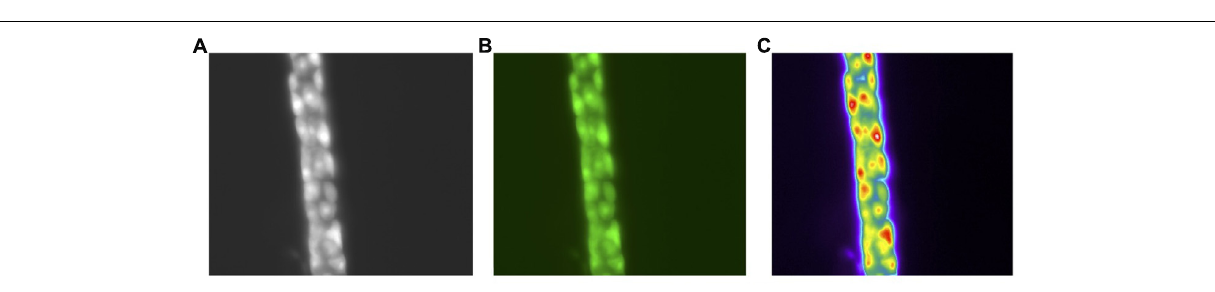
FIGURE 2 | Images of the human gastric gland (A) . Phase contrast of the human gland at 40 × Magnification (B) . pH sensitive dye BCECF-selective loading in parietal cells (C) . Pseudo color image of the parietal cells following stimulation with a secretagogue. All images acquired with a Olympus OM2